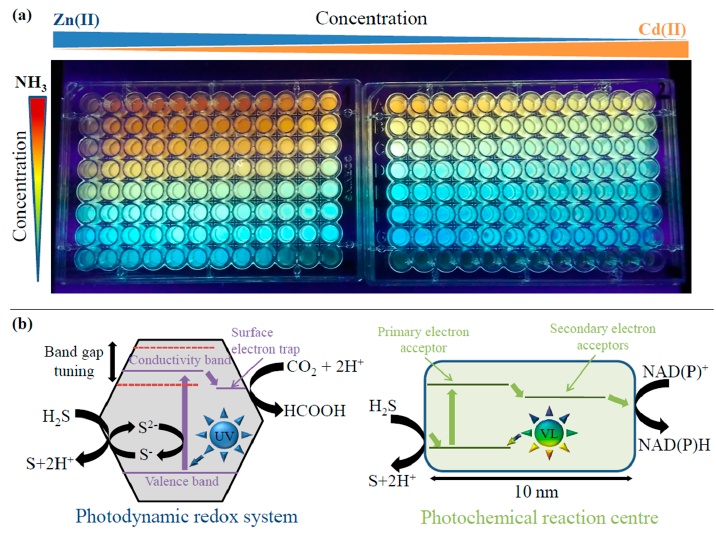
Figure 2. ( a ) Photograph of ZnCd QDs after 8 min UV irradiation of precursors (Zn:Cd:MSA:NH 3 ). ( b ) Schematic representation of photodynamic redox system in comparison with bacterial photochemical reaction center adapted from [46] .